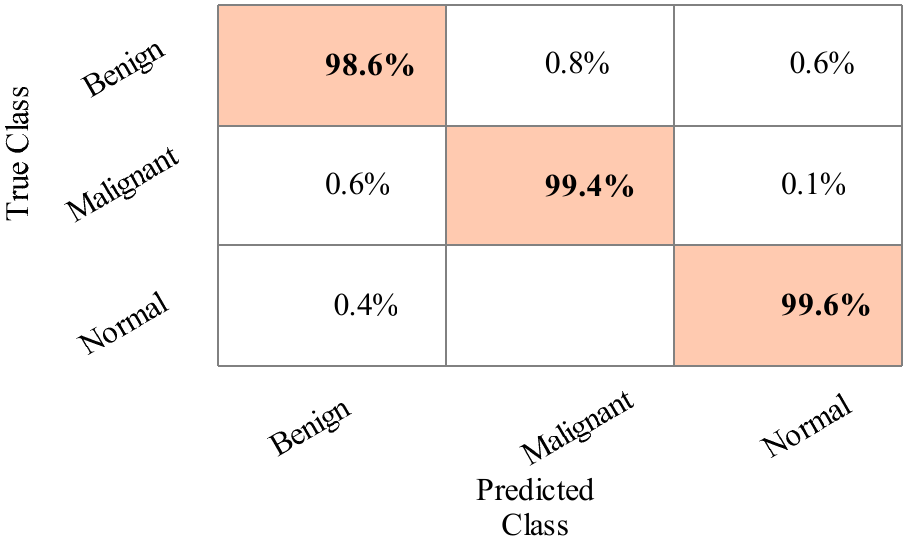
Figure 6. Confusion matrix of Cubic SVM for training/testing ratio of 50:50.